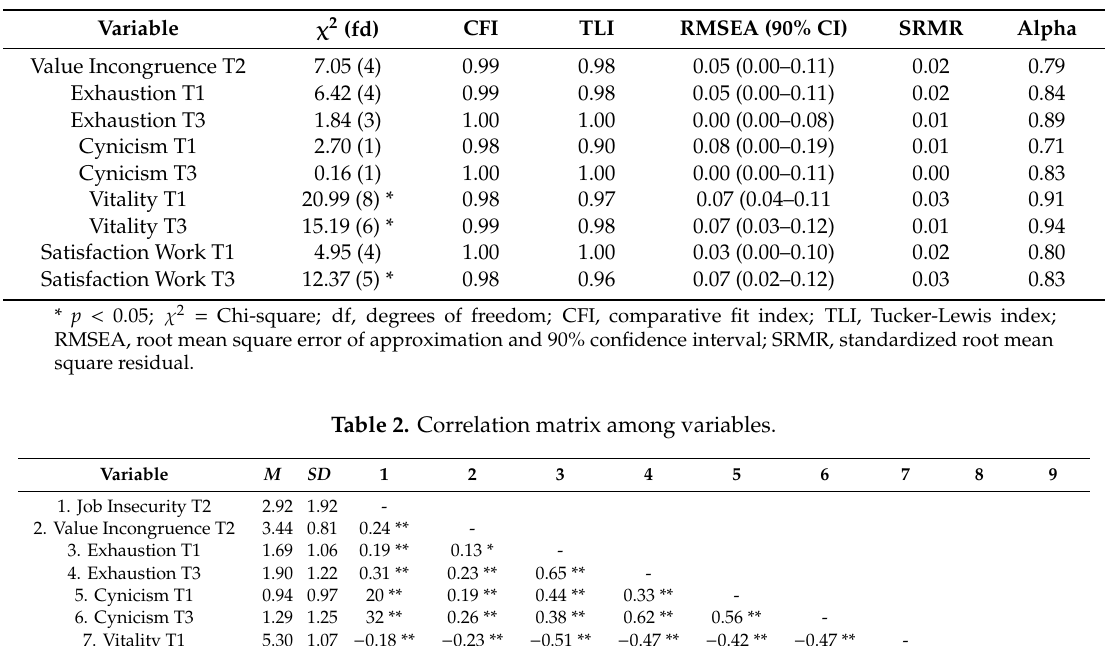
Table 1. Confirmatory factor analysis and alpha values.